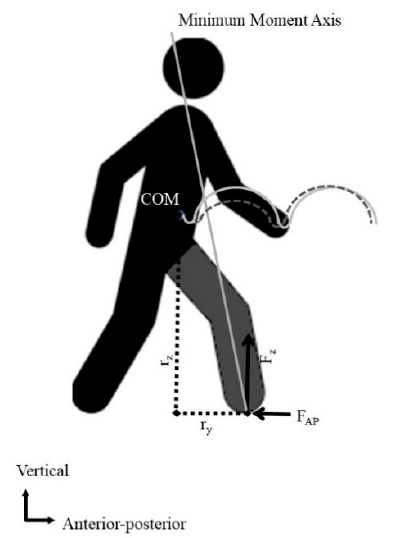
Figure 5. Representation in the sagittal plane of the mechanical parameters involved in the computation of d COM − ∆ . r z : height of COM, r y : the anterior-posterior distance between COM and the intersection of the minimal moment axis ∆ with the ground. The trajectories of COM in the sagittal plane are illustrated as a dashed line (amputee) and full line (healthy subject).